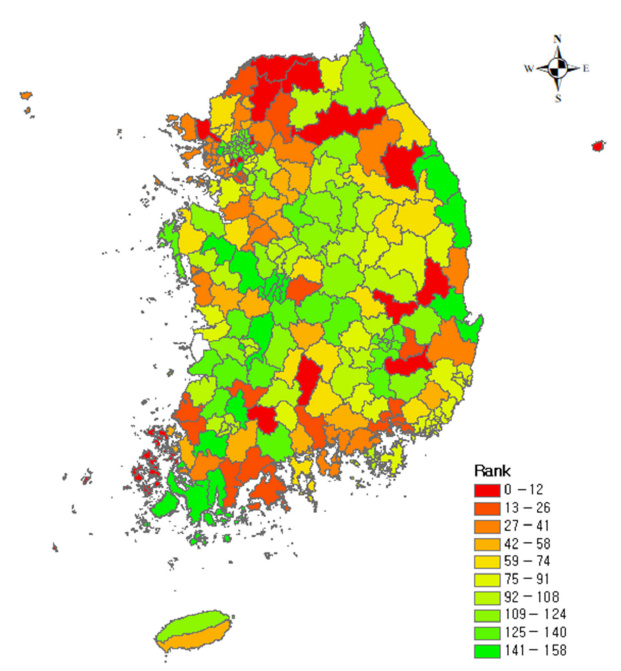
Figure 5. TOPSIS vulnerability assessment